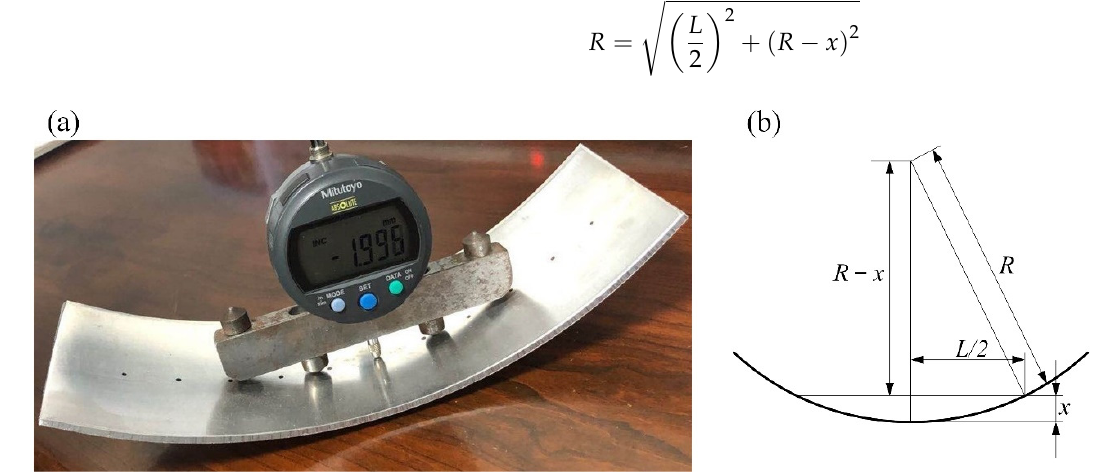
Figure 13. Method of the chord height measurement and the curvature radius calculation of the formed sheet: ( a ) chord height measuring instrument; ( b ) calculation method of curvature radius.